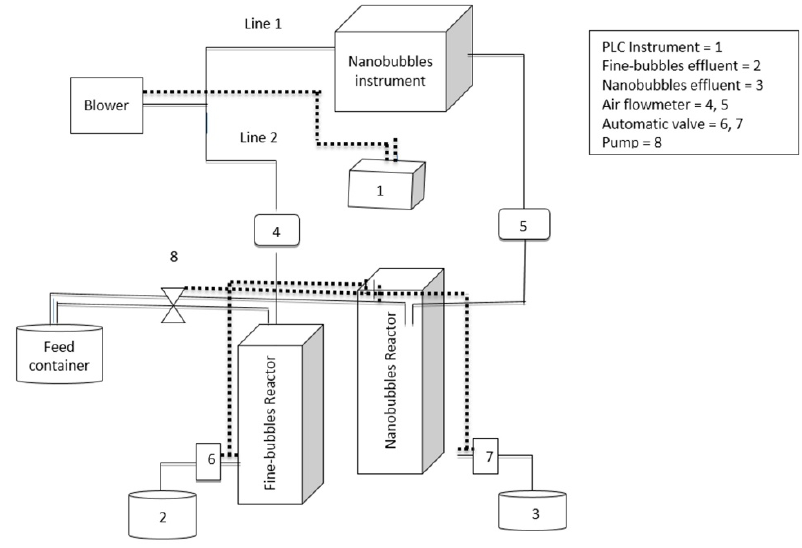
Fig. 1. Schematic diagram of